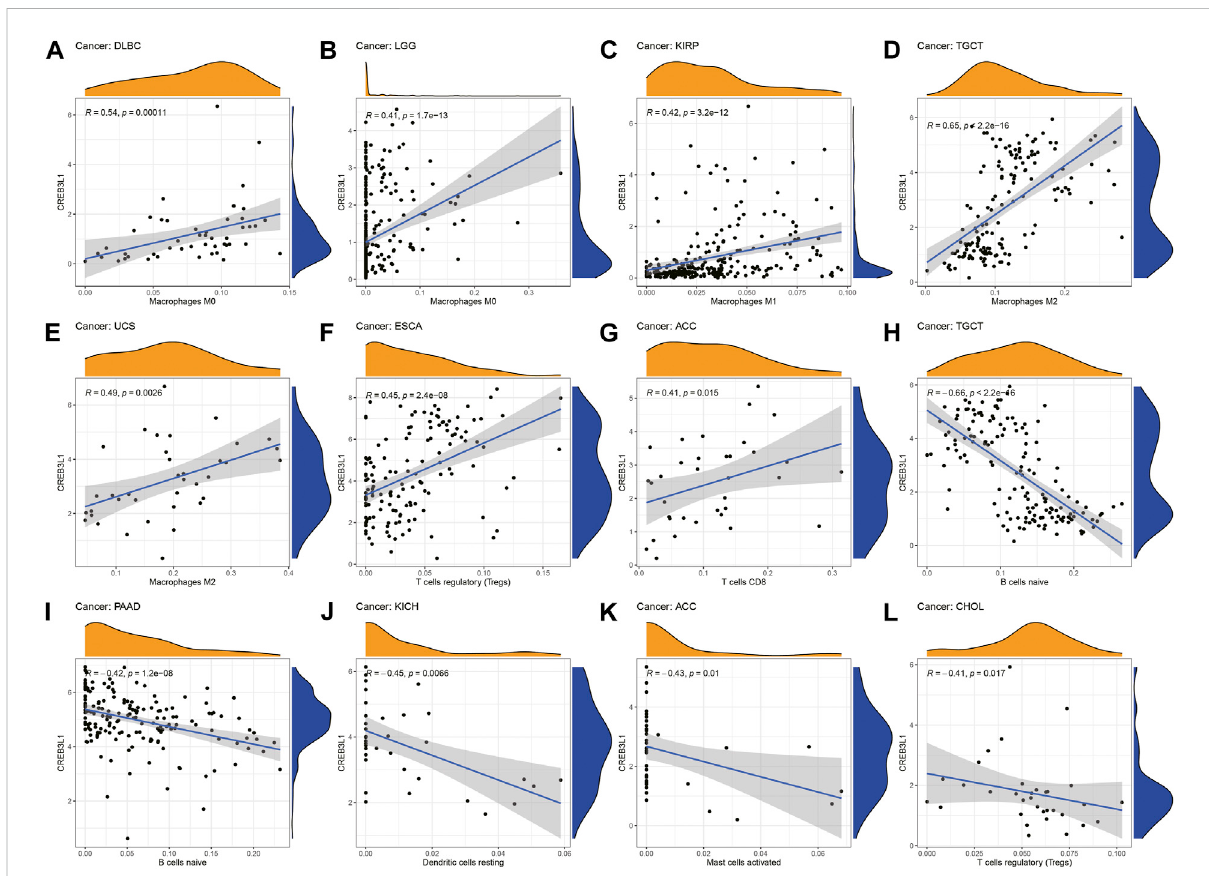
FIGURE 6 The correlation between CREB3L1 expression and the immune cells in fi ltration in pan-cancer. (A – L) CREB3L1 expression was associated with macrophages, regulatory T cells, CD8 + T cells, B cells naïve, dendritic cells and mast cells in different cancer